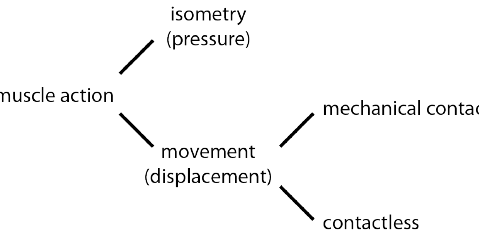
Figure 1. Taxonomy used by Bongers [11]. Movements starts with human muscle action and can be further distinguished into isometric or movement [11]. Reproduced with